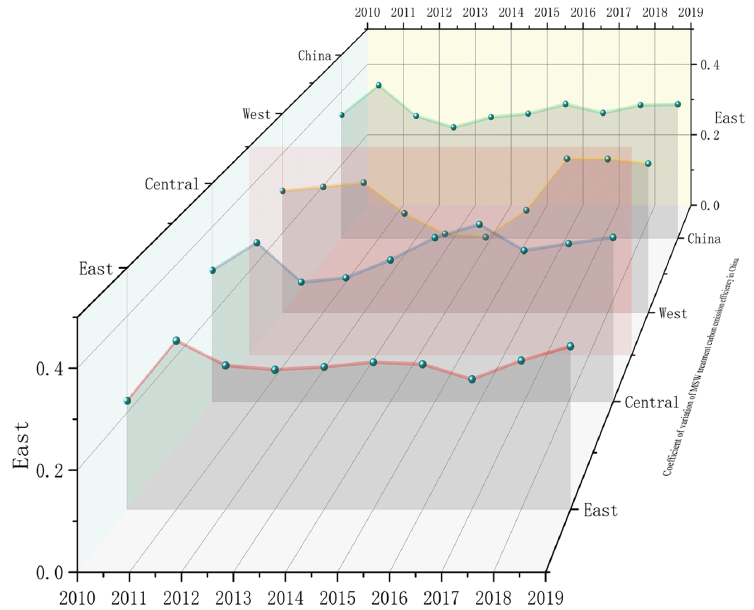
Figure 3. Coefficient of variation of the MSW treatment carbon emission efficiency for the whole of China and for the three regions.